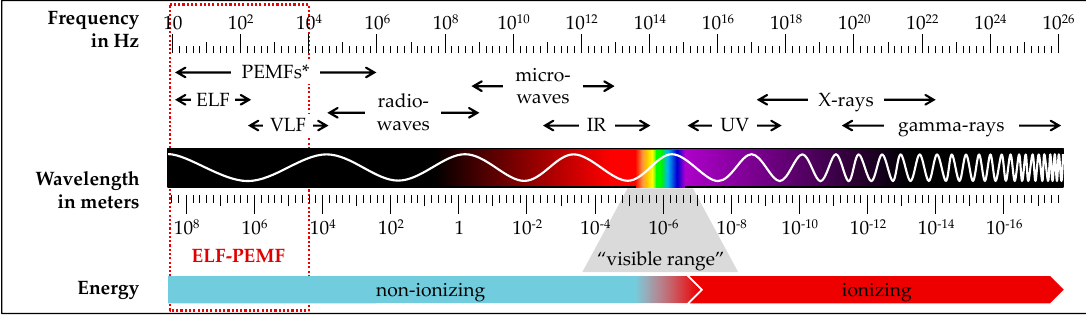
Figure 2. Schematic overview of the terms used for characterizing bursts and pulses of ELF-PEMF. PEMF-signals use periodically repeated bursts consisting of a certain number of pulses, (cid:1840), at a certain frequency, f . The pulses can be described by their shape, amplitude, and pulse width, ∆t (cid:2926) . Here, bursts are repeated at the burst-frequency f (cid:2912) ≪ f . Some publications refer to the magnetic flux